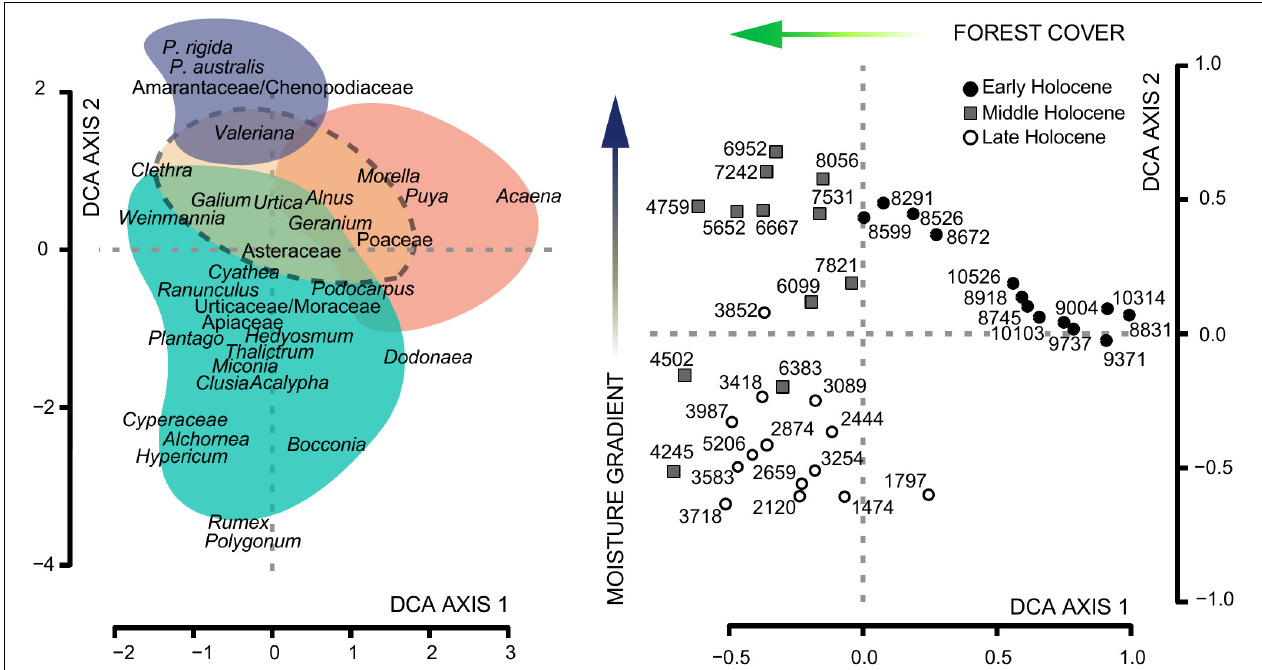
FIGURE 6 | Detrended Correspondence Analysis (DCA) of the pollen record from MAR19-II core from Monquentiva. The left panel shows the DCA species scores for pollen taxa with shaded areas representing main vegetation groups: Páramo (orange); Subpáramo (coral pink); High Andean Forest (cyan); Peatland (purple). The right panel shows DCA sample scores with ages in years before present (BP). Arrows indicate the direction of interpreted environmental